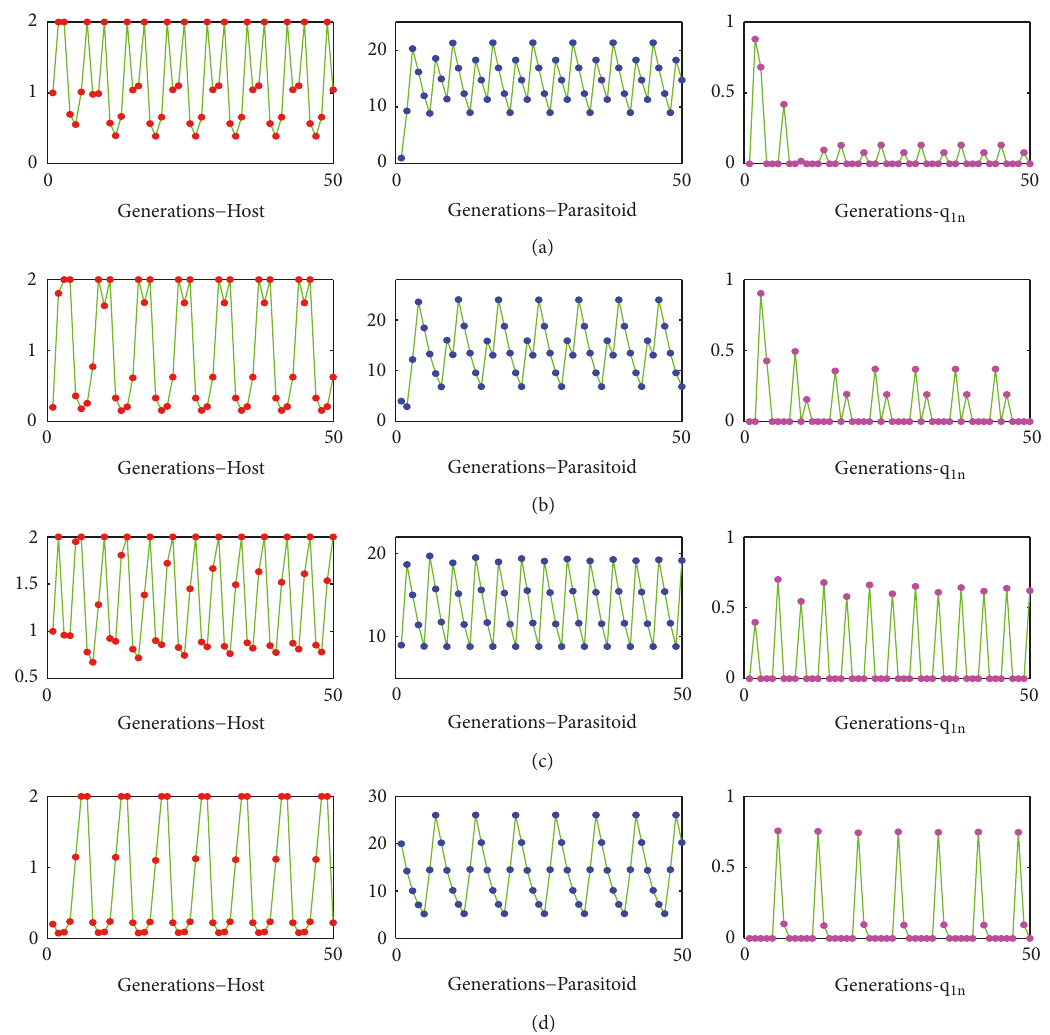
Figure 9: Four coexisting attractors of model (23). Parameters are 𝑟 = 3 , 𝑎 = 0.2 , 𝜎 = 0.7 , 𝑞 𝑚𝑎𝑥 2 = 0.5 , 𝜃 2 = 0.05 , 𝜏 = 8,𝐸𝑇 = 2 . The initial values from top to bottom are (1, 1),(0.2,4),(1, 9), (0.2,20) , respectively, and 𝑞 1 (0) = 0